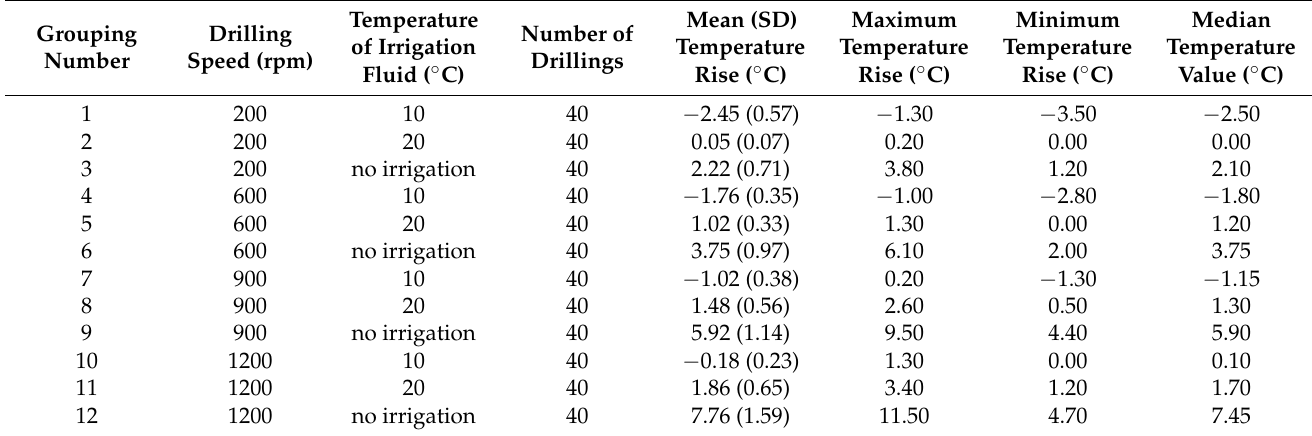
Table 1. Mean temperature rises, maximum and minimum of temperature rises, groups divided by different drilling speeds, and temperature of the irrigation